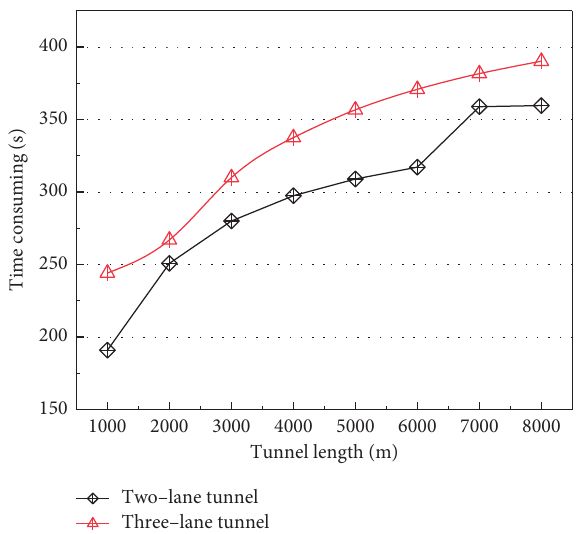
Figure 14: Time needed for the formation of stable reverse v tunnels of different